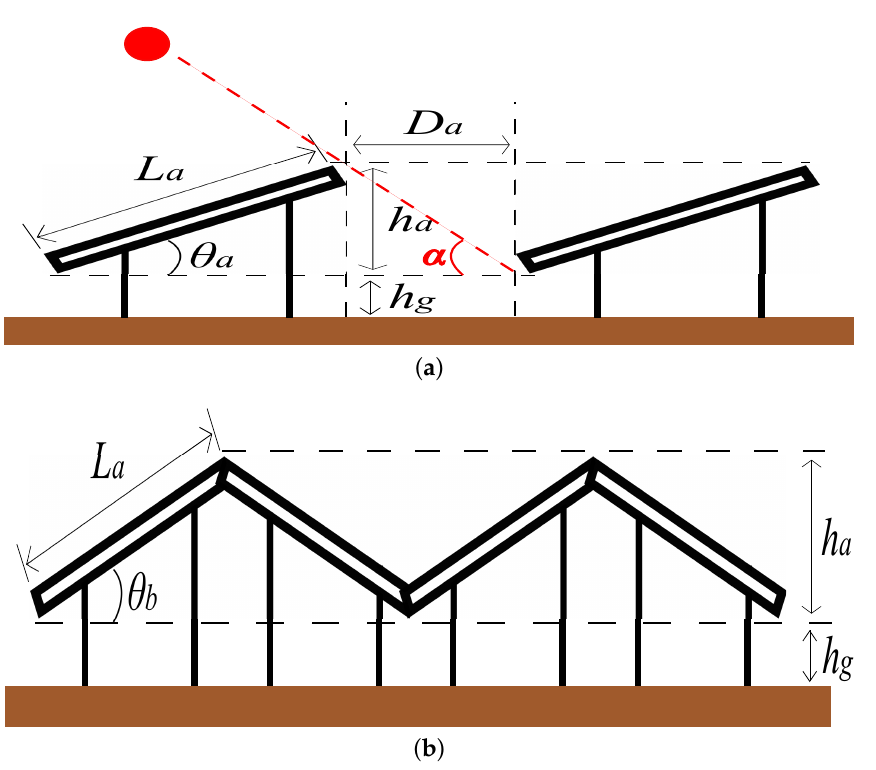
Figure 2. Schematic diagram of S- and M-shaped PV arrangement [20]. ( a ) S-shaped PV arrangement schematic; ( b ) M-shaped PV arrangement